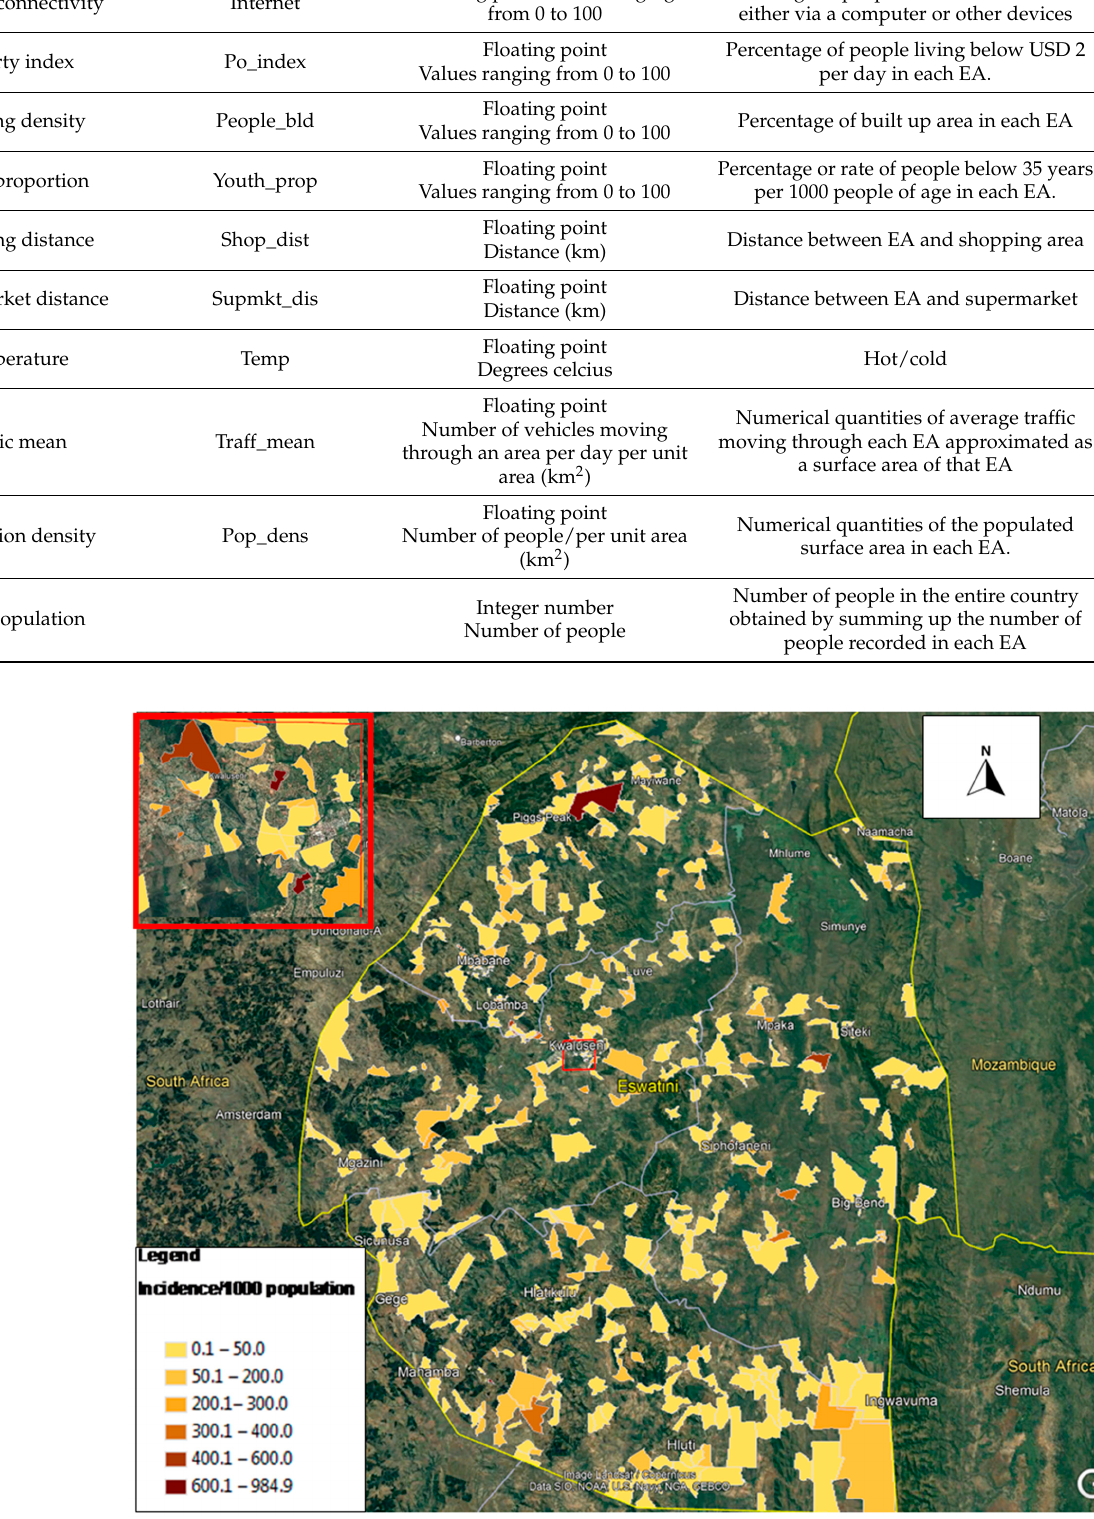
Figure 2. Distribution of COVID-19 cases per 1000 population in Eswatini. Table 1. Health, Demographic and Socio-Economic Data.